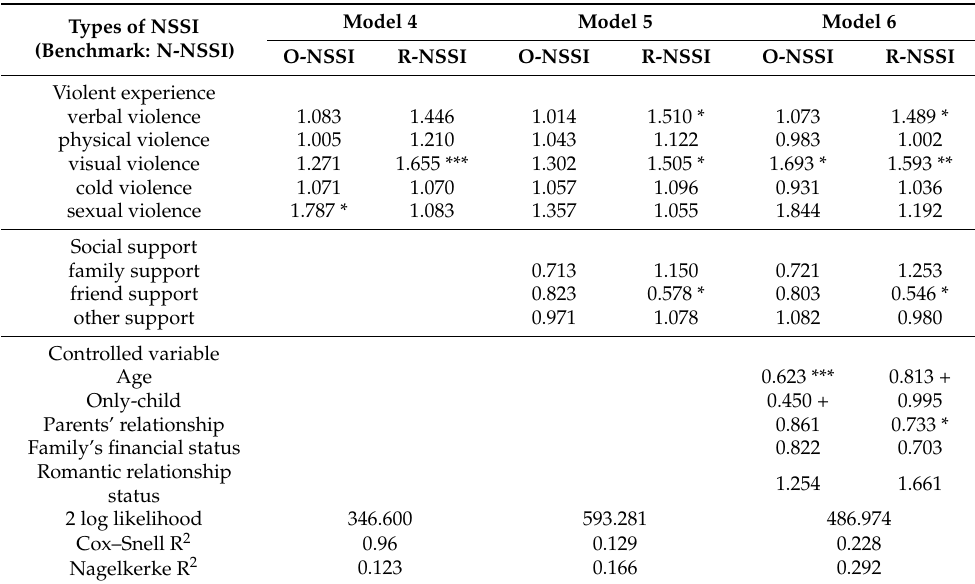
Table 3. Violent experience and social support on NSSI and R-NSSI behaviors of female students. Types of NSSI (Benchmark: